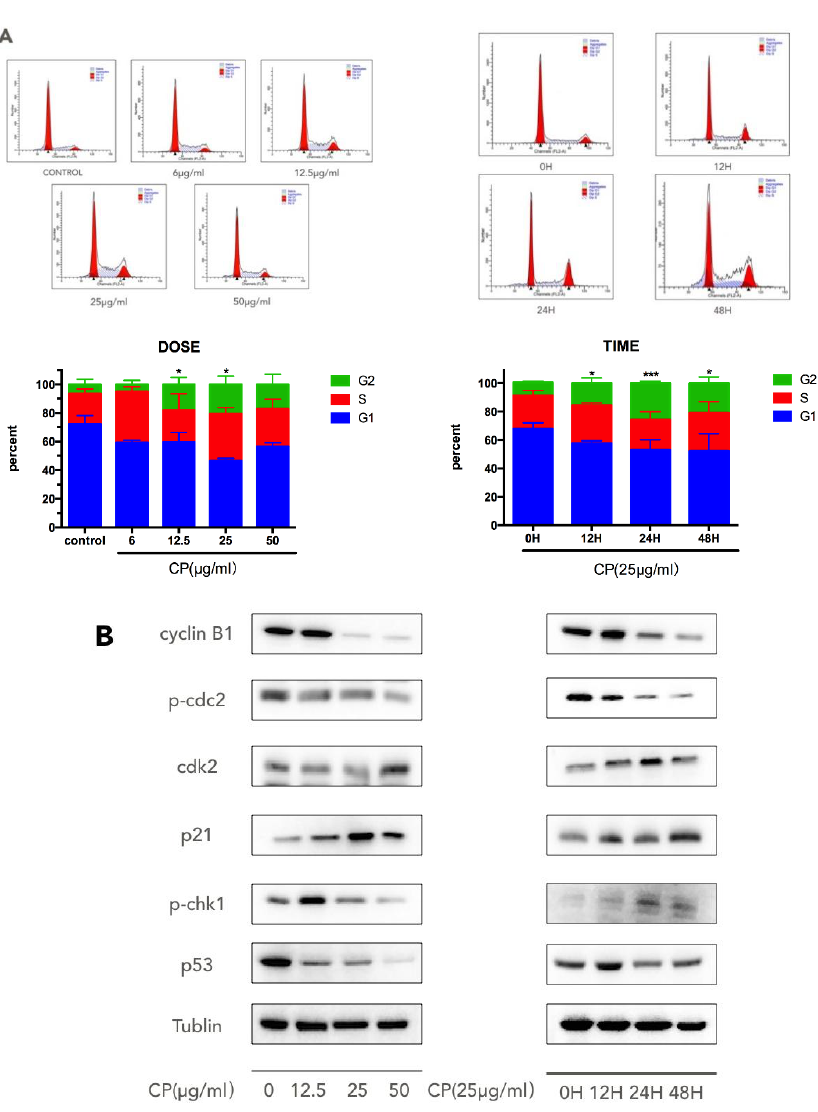
Figure 2. Chinese propolis (CP) triggered G2/M phase arrest in human melanoma. ( A ) The changes in the distribution of cell cycle phases after CP treatment. A375 cells were treated with 6 µ g/mL, 12.5 µ g/mL, 25 µ g/mL and 50 µ g/mL CP for 48 h or with 25 µ g/mL CP for 6 h, 12 h, 24 h and 48 h. * p < 0.05 and *** p < 0.001 for the designated treatment versus the control (vehicle); ( B ) The expression of cell cycle regulation proteins was measured by Western